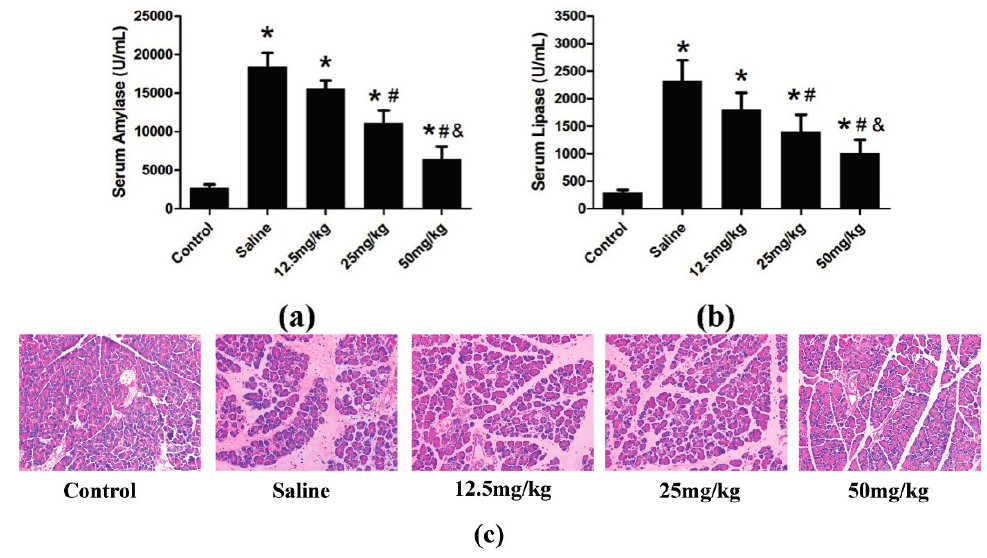
Figure 1. AP was induced in rats ( n = 4 in each group) by treatment with 4% STC. Saline or catalpol (12.5, 25 and 50 mg/kg) was administered 2 h before STC injection. The control group was administered saline (0.9% NaCl) instead of STC. Rats were sacrificed 24 h after STC injection. Blood samples were collected, and levels of serum amylase ( a ) and lipase ( b ) were measured, and the staining of hematoxylin and eosin (H&E) of pancreas were showed ( c ). Original magnifications: ×200, all specimens were scored by three pathologists who were unaware of their origin. Data are presented as means ± SD from three independent experiments. * p < 0.05, compared with the control group; # p < 0.05, compared with the saline-treated group; & p < 0.05, compared with 25 mg/kg catalpol-treated